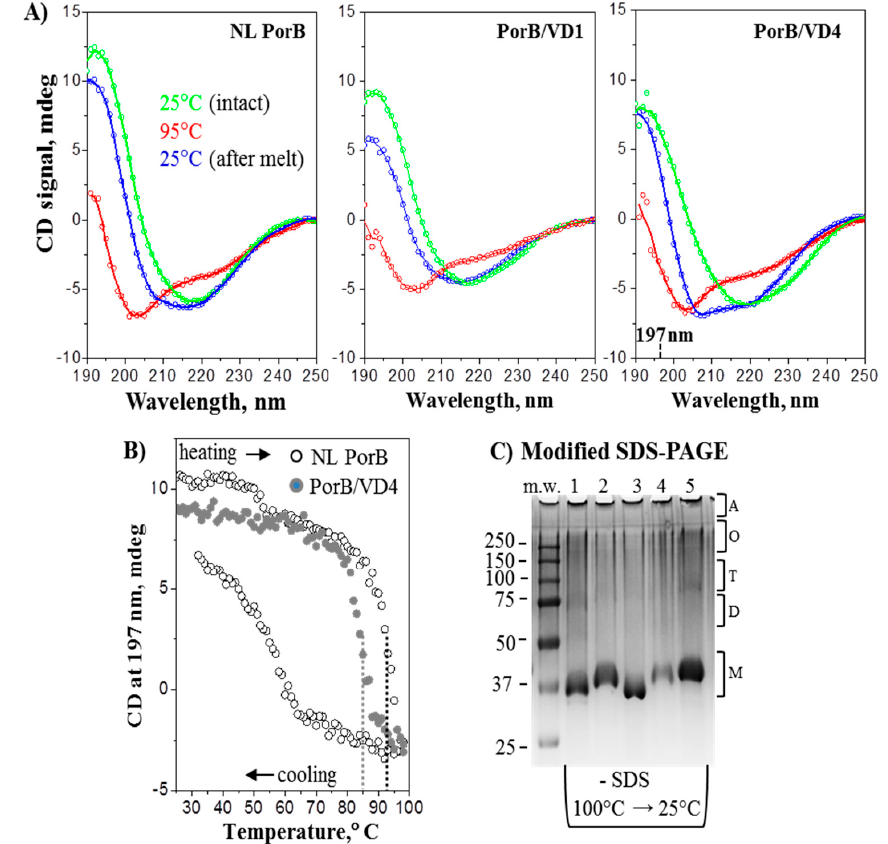
Figure 4. Secondary structure and thermal stability of PorB/VDs. ( A ) Far-UV CD spectra of NL PorB, PorB/VD1 and PorB/VD4 (left to right) representative of the PorB/VDs. In each panel, three consecutive spectra were recorded of the same sample (0.18 mg/mL protein in 10 mM sodium phosphate and 0.05% Zwittergent 3–14 at pH 8.0). Green lines: intact sample at 25 ◦ C. Blue lines: sample was heated to 98 ◦ C and cooled to 25 ◦ C, followed by data collection at 25 ◦ C. Red lines: sample was incubated at 95 ◦ C for 5 min and the data was recorded at 95 ◦ C. ( B ) Representative thermal denaturation data recorded at 197 nm during sample heating from 25 ◦ C to 98 ◦ C, followed by cooling to 25 ◦ C at a rate of 70 ◦ C/h. Sample conditions are as in panel A. The directions of the temperature changes are indicated. Vertical dotted lines indicate the midpoints of thermal unfolding. ( C ) Coomassie staining of modified SDS-PAGE. Samples were dissolved in SDS-free loading buffer, heated at 100 ◦ C for 5 min. and cooled to 25 ◦ C prior to electrophoresis. Lane 1: NL PorB; Lane 2: PorB/VD1 Lane 3: PorB/VD2; Lane 4: PorB/VD3; Lane 5: PorB/VD4. The predicted position of bands of molecular weight corresponding to monomers (M), dimers (D), trimers (T), oligomeric forms (O) and aggregates (A) are